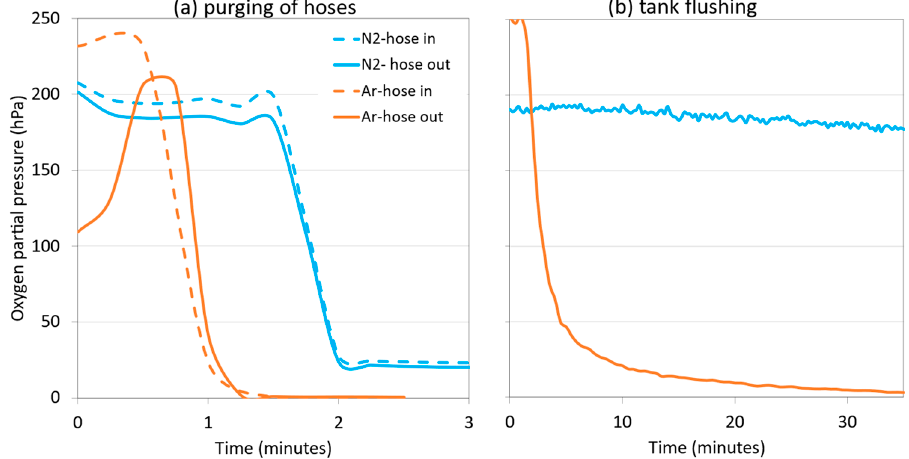
Figure 11. Comparison of oxygen content during purging of hoses (DN50 and L = 20 m) ( a ) and of an empty 25,000 L tank with N 2 and Ar in a commercial white wine cellar ( b ).